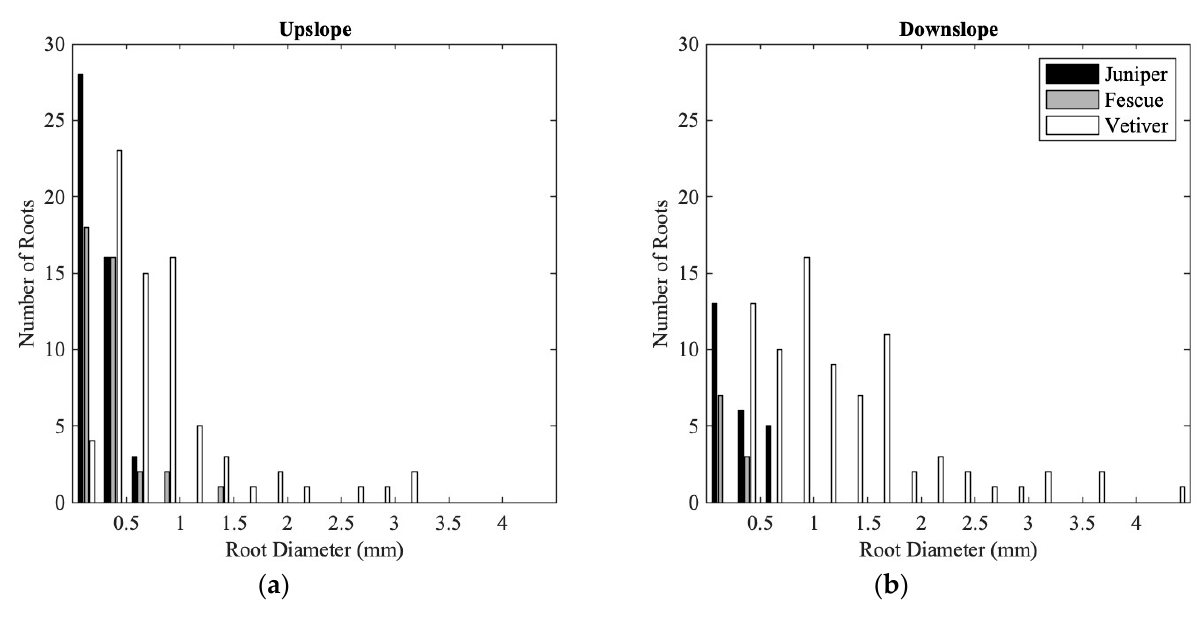
Figure 12. Histograms of root diameter measured at the midpoint of roots extracted from the ( a ) upslope core; and ( b ) downslope core.